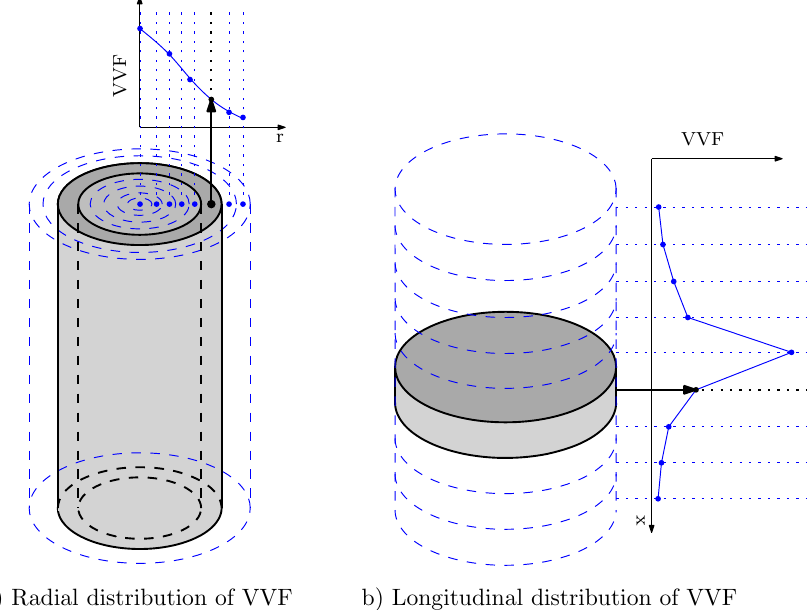
Figure 11. Schematic representation of the volumes used to obtain a point of the VVF distribution for both